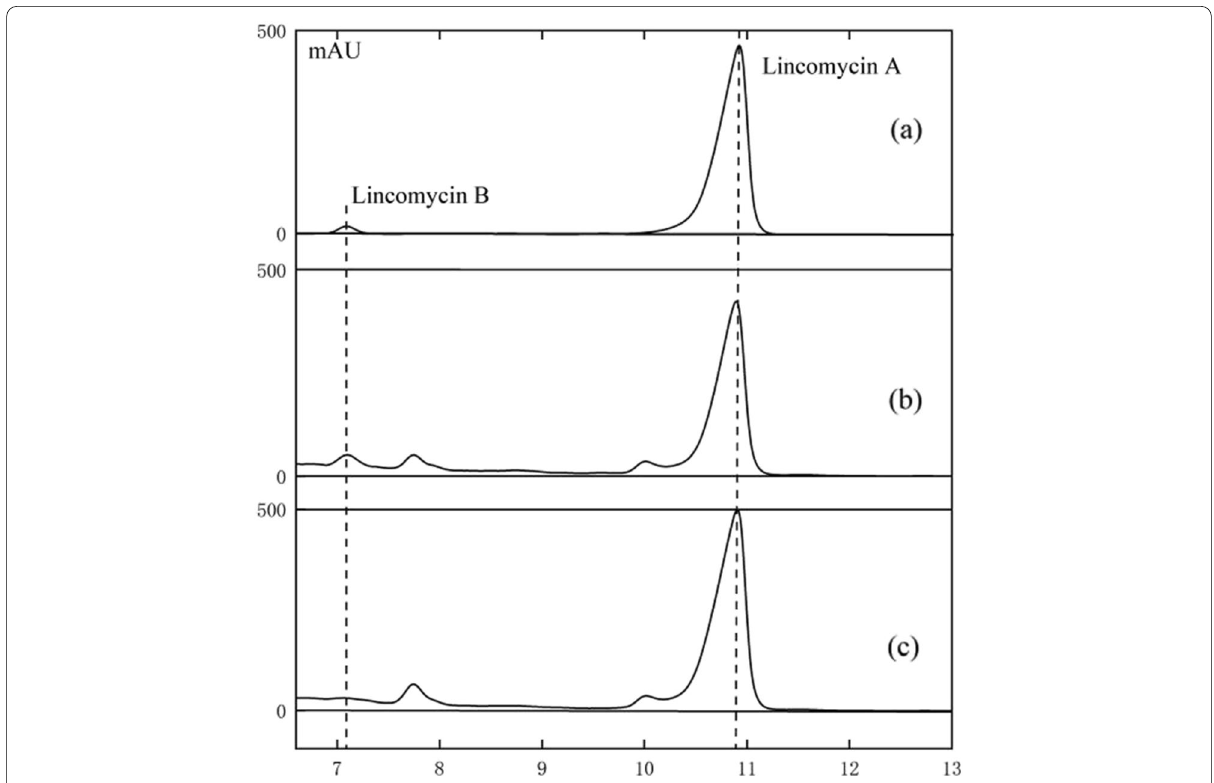
Fig. 2 HPLC analysis of lincomycin production during Streptomyces. lincolnensis fermentation. a Standard lincomycin A and lincomycin B. b Lincomycin A and lincomycin B produced by the initial medium. c Lincomycin A and lincomycin B produced by the optimized